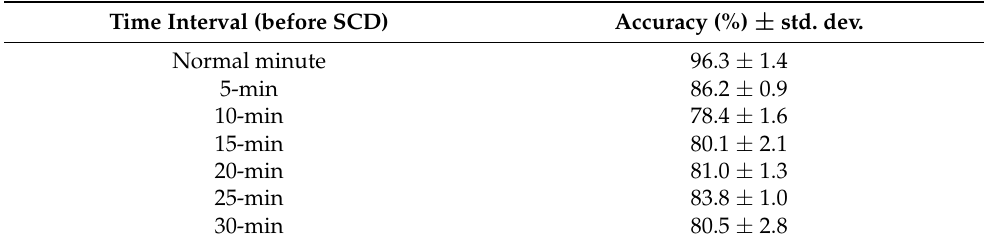
Table 5. ECG SCD classification through sparse representations based on the proposed multi-class